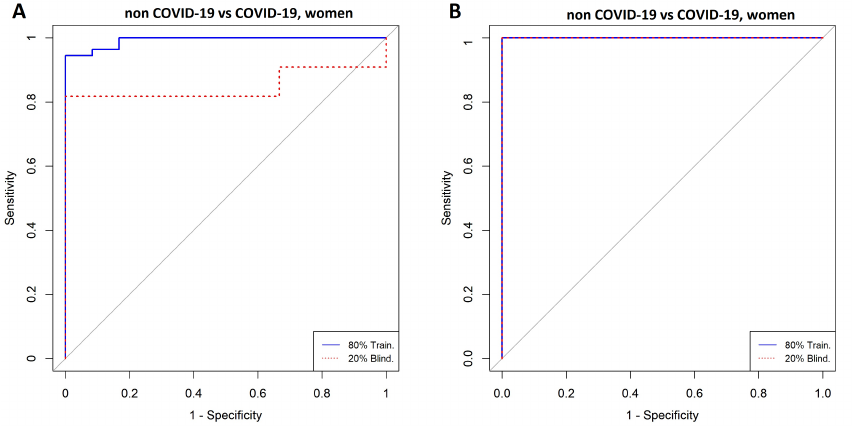
Figure 7. ROC curves for the classification of women with COVID-19 vs. women without COVID-19. ( A ) Logistic Regression and ( B ) Support Vector Machine. Model A was built with C10:2, cough, alpha ketoglutaric acid, lysoPC a 26:0, lysoPC a 28:0, histidine, fever, anosmia, propionic